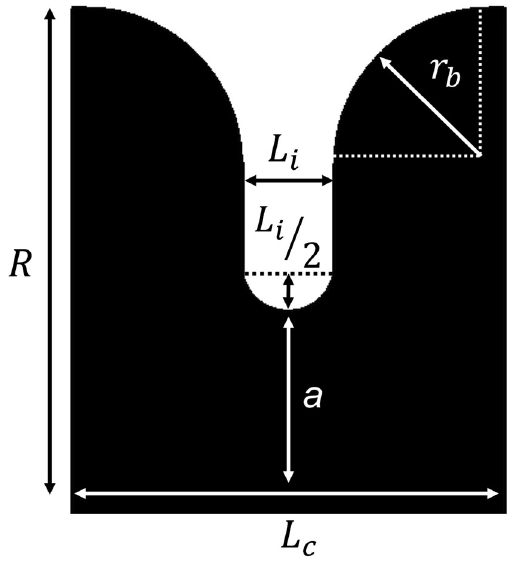
FIG. 3. Geometrical parameters of the single